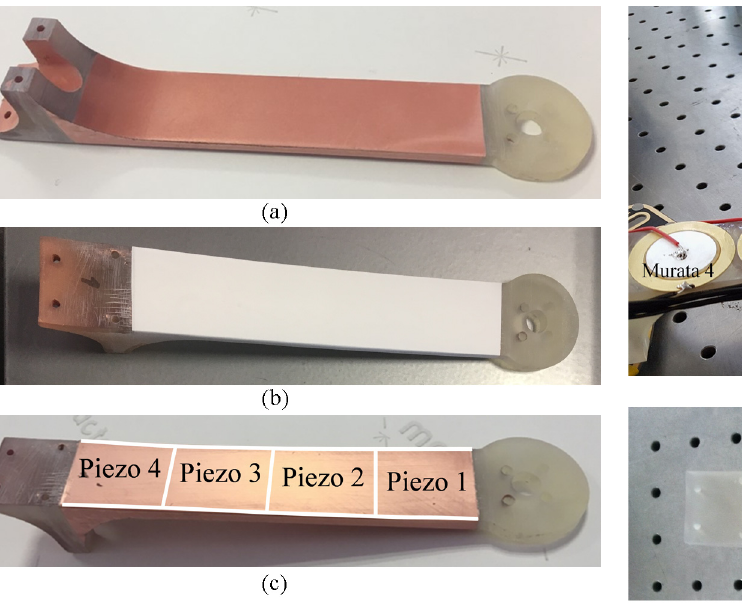
Fig. 11. Manufacturing steps of the “ integrated piezoelectric arm ” : (a) after deposition of the fi rst copper layer (Ampère), (b) after deposition of the piezoelectric layer (LGEF), (c) after deposition of the second copper layer (Ampère).